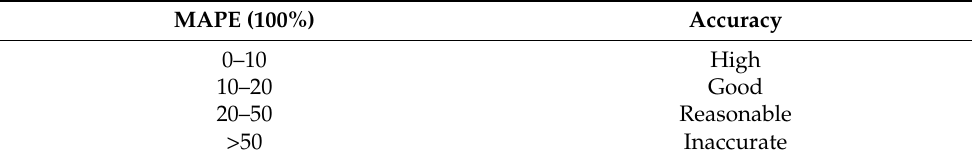
Table 1. The criterion for MAPE.